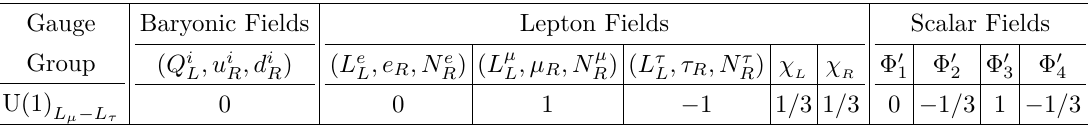
Table 3 . L µ − L τ charges for fermions and scalars of the present